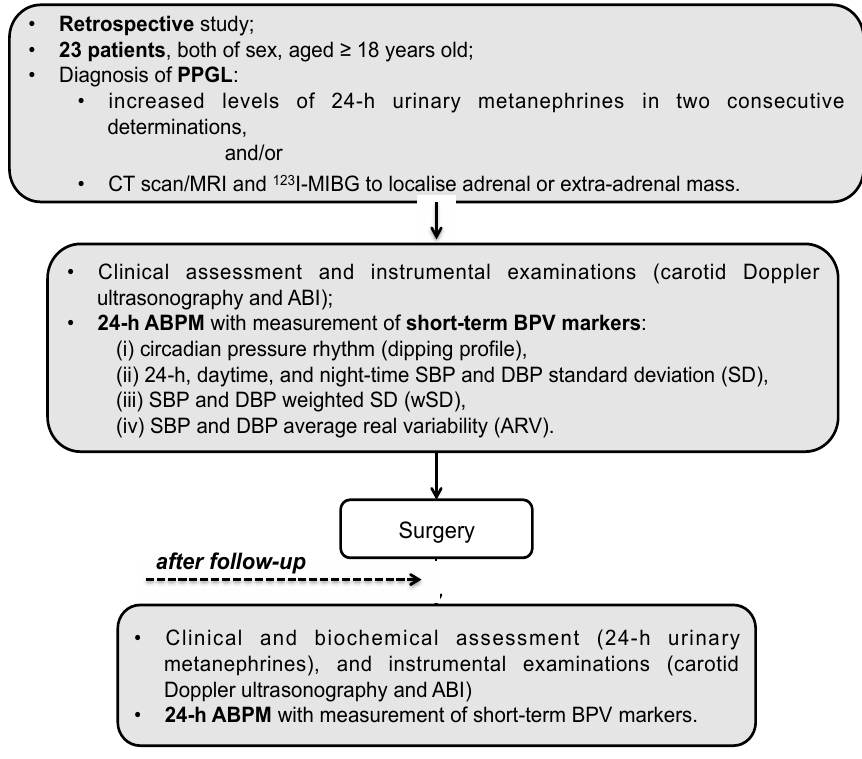
Figure 1. Flow-chart of the study. PPGL, pheochromocytoma and paraganglioma; CT, computed tomography; MRI, magnetic resonance imaging; MIBG, metaiodobenzylguanidine; ABI, ankle-brachial index; SBP, systolic blood pressure; DBP, diastolic blood pressure; SD, standard deviation .